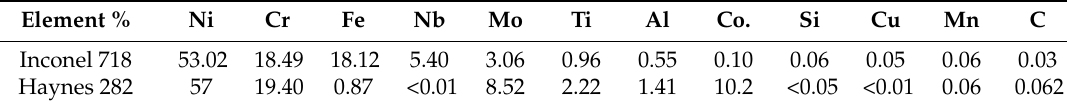
Table 1. Chemical composition of Inconel 718 and Haynes 282 superalloys (wt %) [19]. Element % Ni Cr Fe Nb Mo Ti Al Inconel